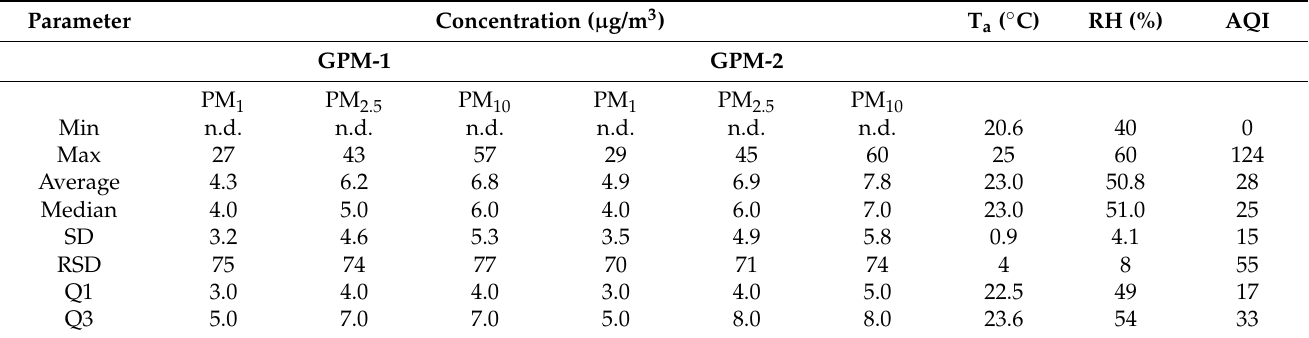
Table 1. Air-monitoring data for GPM sensors collected indoors at the urban sampling site (living room) between 27 and 30 May 2021 (sampling rate: 10 s, n = 28,750).